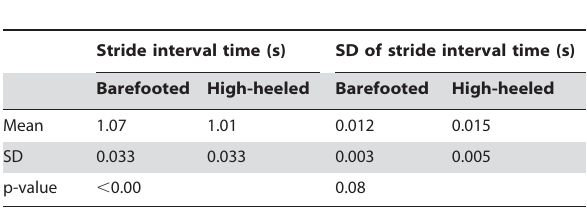
Table 1. Stride interval time and standard deviation (SD) of stride interval time.